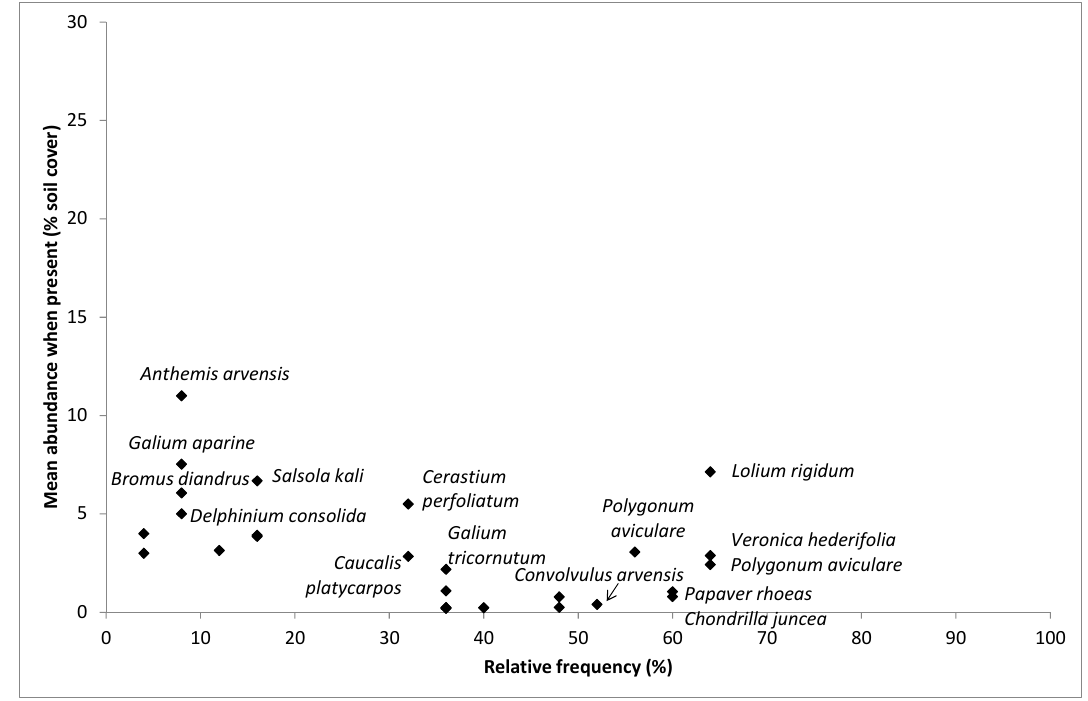
Figure 3. Species relative frequency and mean abundance when present in cereal monocrop fields (CM). Data of years 2011–2014 pooled together. Named species are the most abundant and most frequent ones.